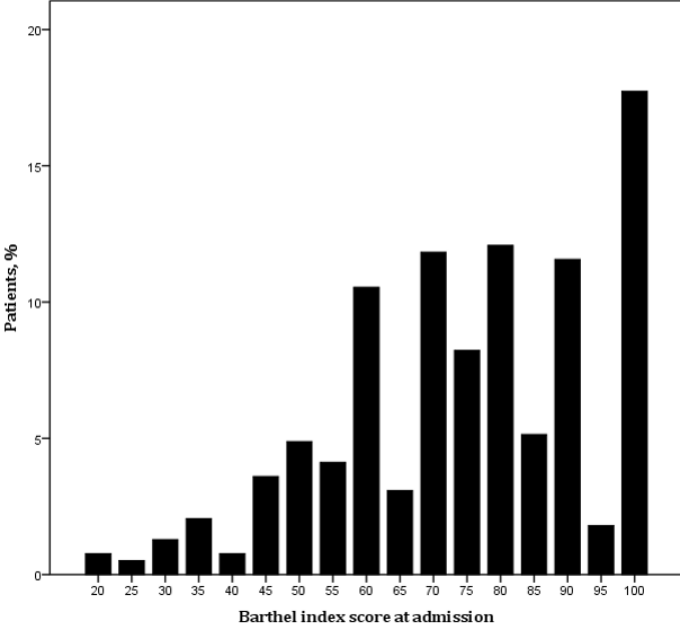
Figure 1. Barthel index score distribution in our sample.